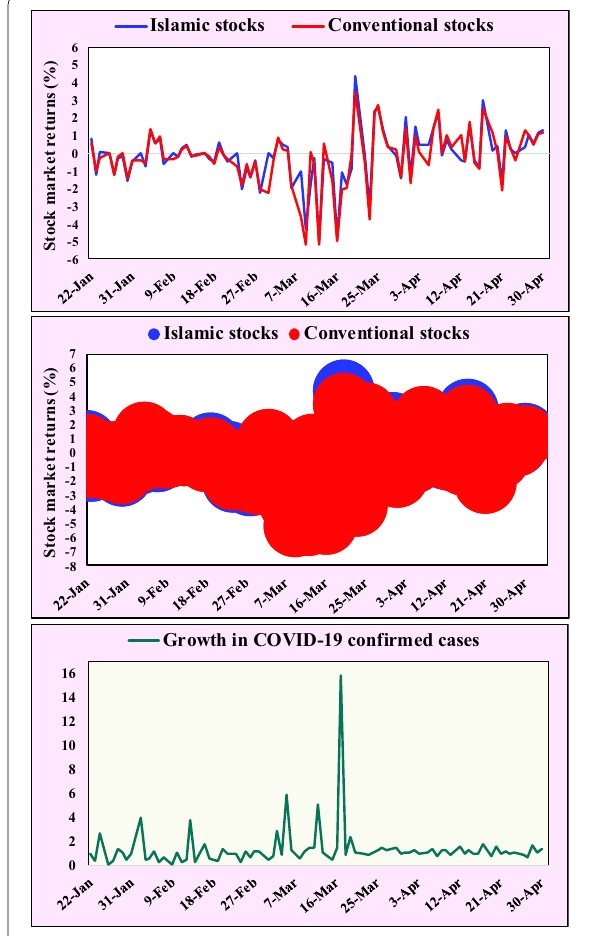
Fig. 2 Islamic versus conventional stock market returns (%) for the full sample against the date from the day when 1st COVID-19 case was confirmed and growth in confirmed cases in a country (returns on average)